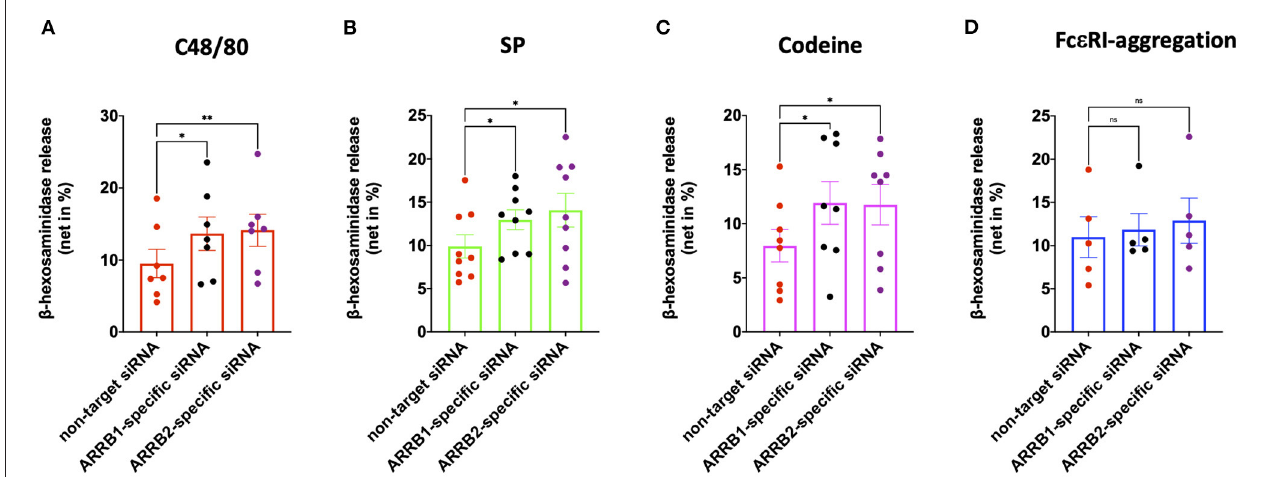
FIGURE 1 | MRGPRX2 but not Fc ε RI-driven degranulation is regulated by β -arrestin-1 and β -arrestin-2. Human skin derived MCs were treated with ARRB1-selective, ARRB2-selective or non-target siRNA for 48h. The cells were then stimulated with (A) c48/80 (10 µ g/ml), (B) SP (30 µ M), (C) codeine (100 µ g/ml), or (D) Fc ε RI aggregation (AER-37, 0.1 µ g/ml). Degranulation was determined by β -hexosaminidase release. Each dot represents an independent culture, the data shown are mean ± SEM of n = 5-9. * p < 0.05, ** p < 0.01, and ns, not significant.